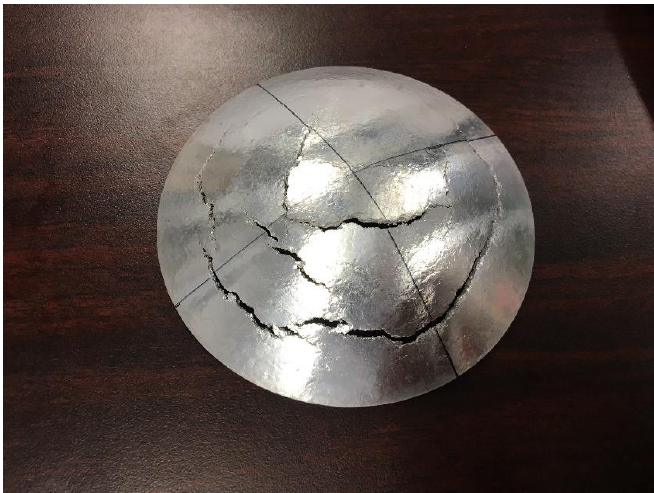
Figure 18. AZ91 plate and an auxiliary plate composed of aluminum alloy.